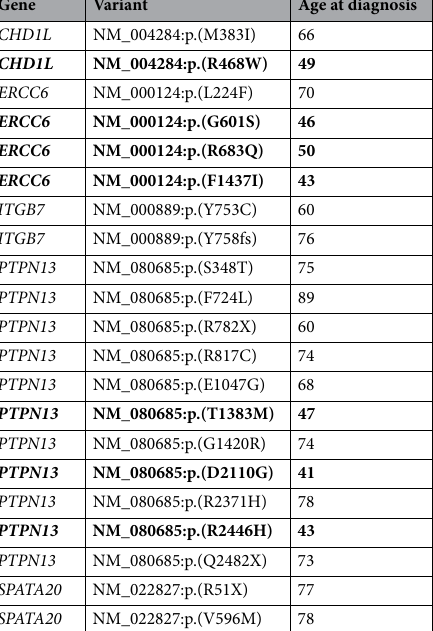
Table 3. Variants in the candidate genes in TCGA CRC samples. Twenty-one variants in five of the candidate genes were found in TCGA CRC COAD/READ samples. Seven of these were found in patients under 50 years of age (in